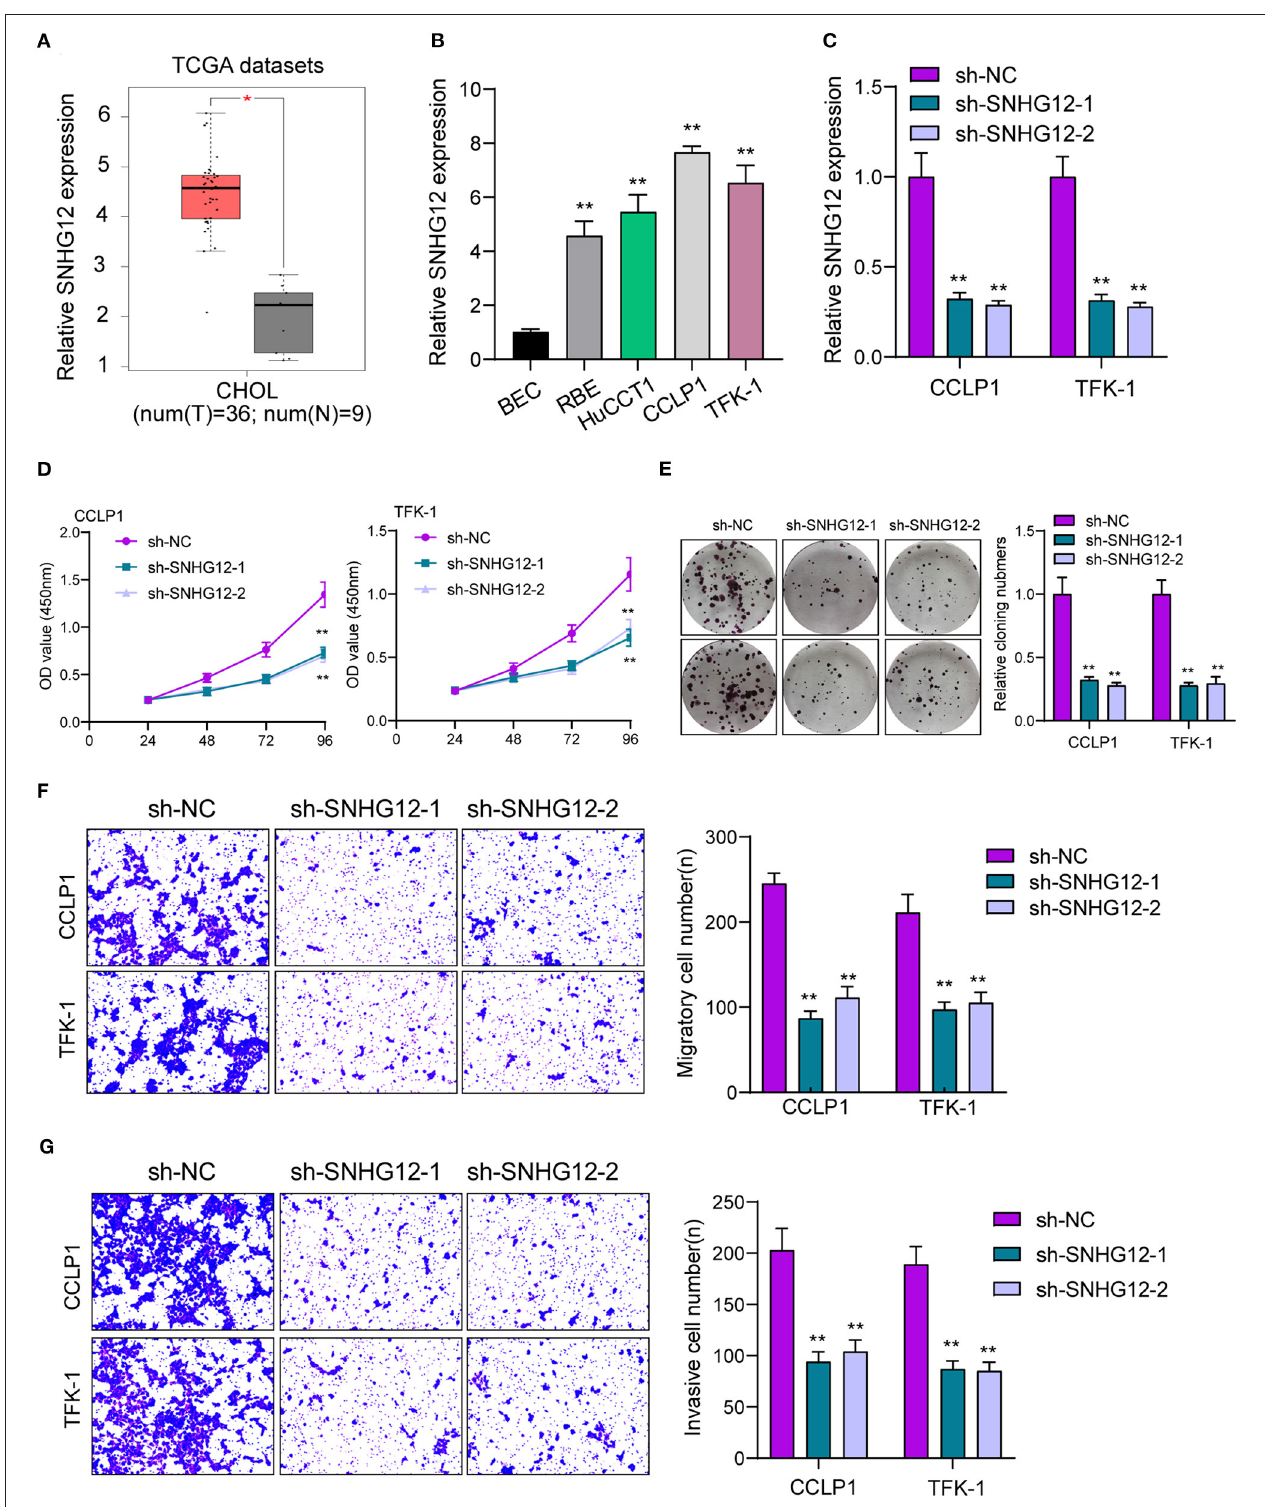
FIGURE 1 | Increased SNHG12 expression and its oncogenic roles in ICC cells. (A) Higher levels of SNHG12 were observed in ICC specimens than normal specimens by amazing TCGA datasets. (B) RT-PCR determined the expressions of SNHG12 in ICC cells and BEC cells. (C) SNHG12 expression was examined in TFK-1 and CCLP1 cells transfected with sh-NC, sh-SNHG12-1 or sh-SNHG12-2. (D) Cell proliferation analysis. TFK-1 and CCLP1 cells were detected for 24, 48 and 72h after transfection. (E) Proliferation of TFK-1 and CCLP1 cells transfected with sh-SNHG12-1 or sh-SNHG12-2 as determined by colony formation assays. (F,G) Transwell assays were used to detect cellular invasion and migration in SNHG12-knockdown TFK-1 and CCLP1 cells. * p < 0.05, ** p < 0.01.